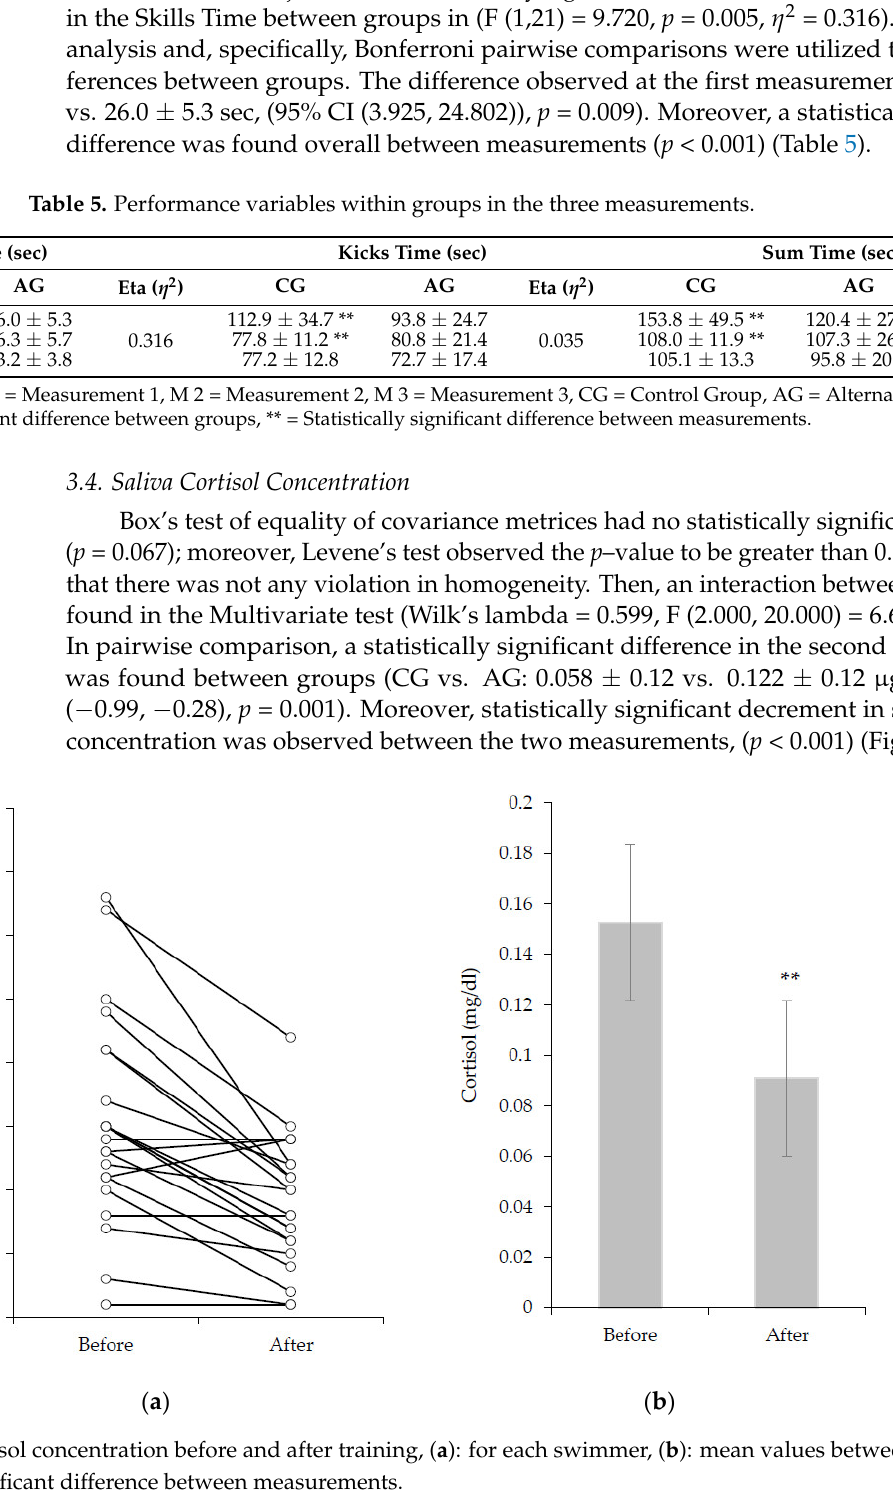
Table 5. Performance variables within groups in the three measurements.